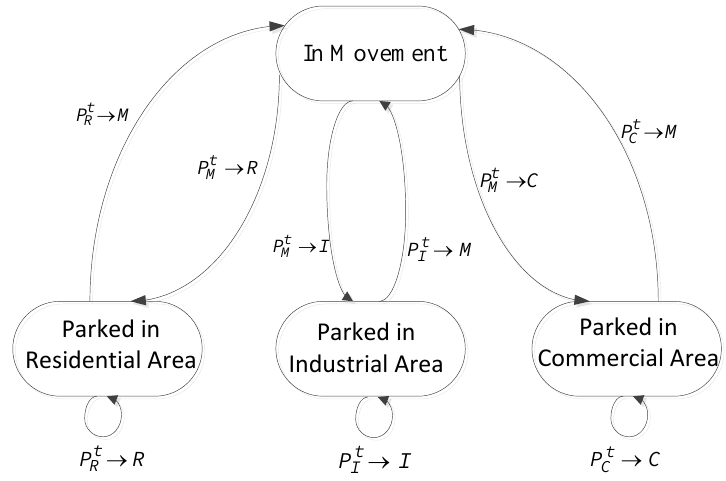
Figure 6. An example of discrete state and discrete time of a Markov chain model for modelling the driving pattern of a plug-in electric vehicle fleet (PEVF).